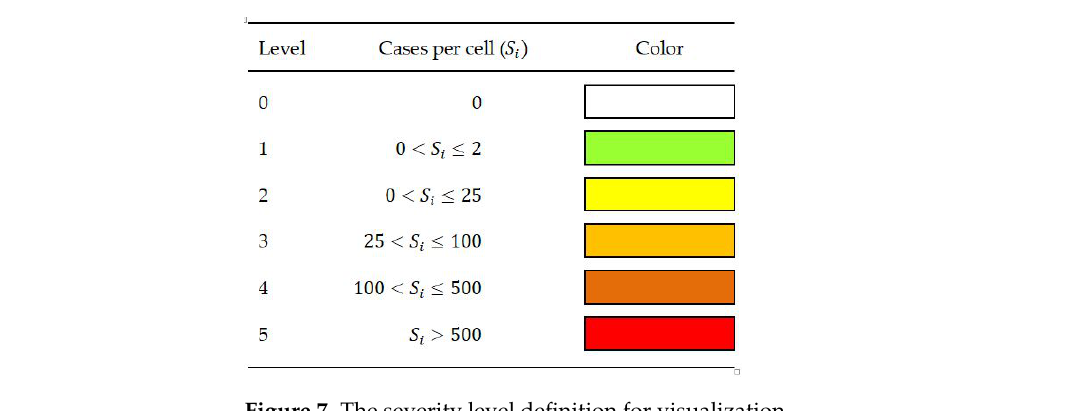
Figure 7. The severity level definition for visualization.